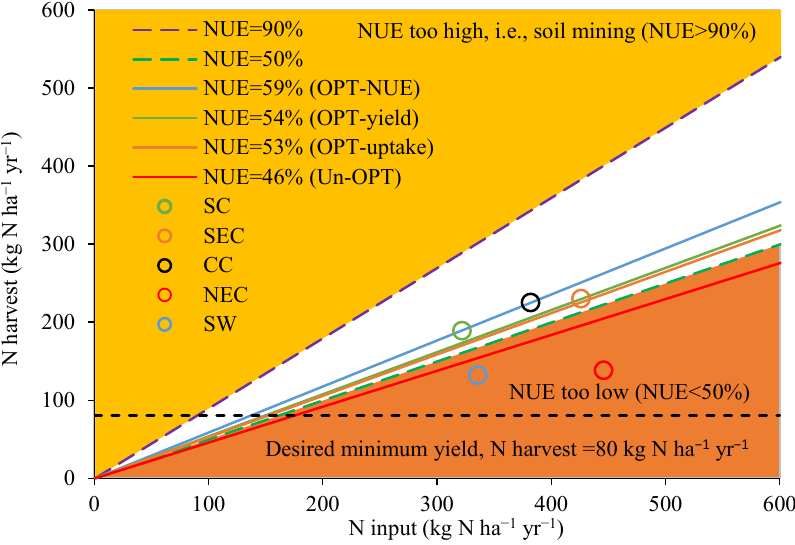
Figure 4. Comparison of N input and N harvest under different N managements of RR in China. N harvest indicates grain N uptake; N input includes fertilizer N, N deposition, biological N fixation, and seed N; the yellow and orange parts indicate high-NUE and low-NUE areas (data from Zhang C [13]); open circles denote data under Un-OPT in the five RR planting areas of China. The desirable ranges NUE = 90% and NUE = 50%, and the desired minimum yield level (N harvest = 80 kg ha −1 yr −1 ) were suggested by the EU Nitrogen Expert Panel (EU Nitrogen Expert Panel 2015 [37]).